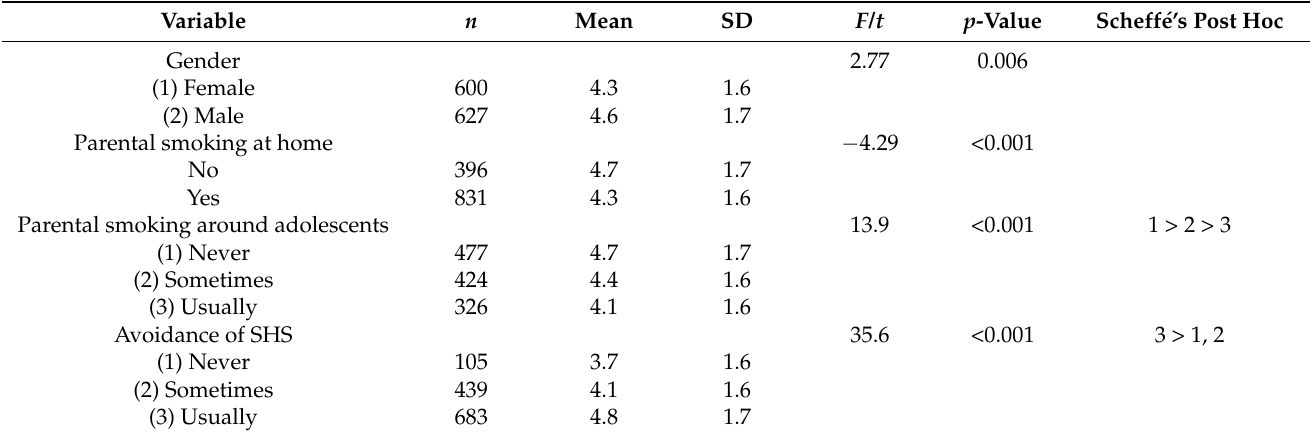
Table 2. Factors associated with adolescents’ health-promoting behaviors ( n = 1227).